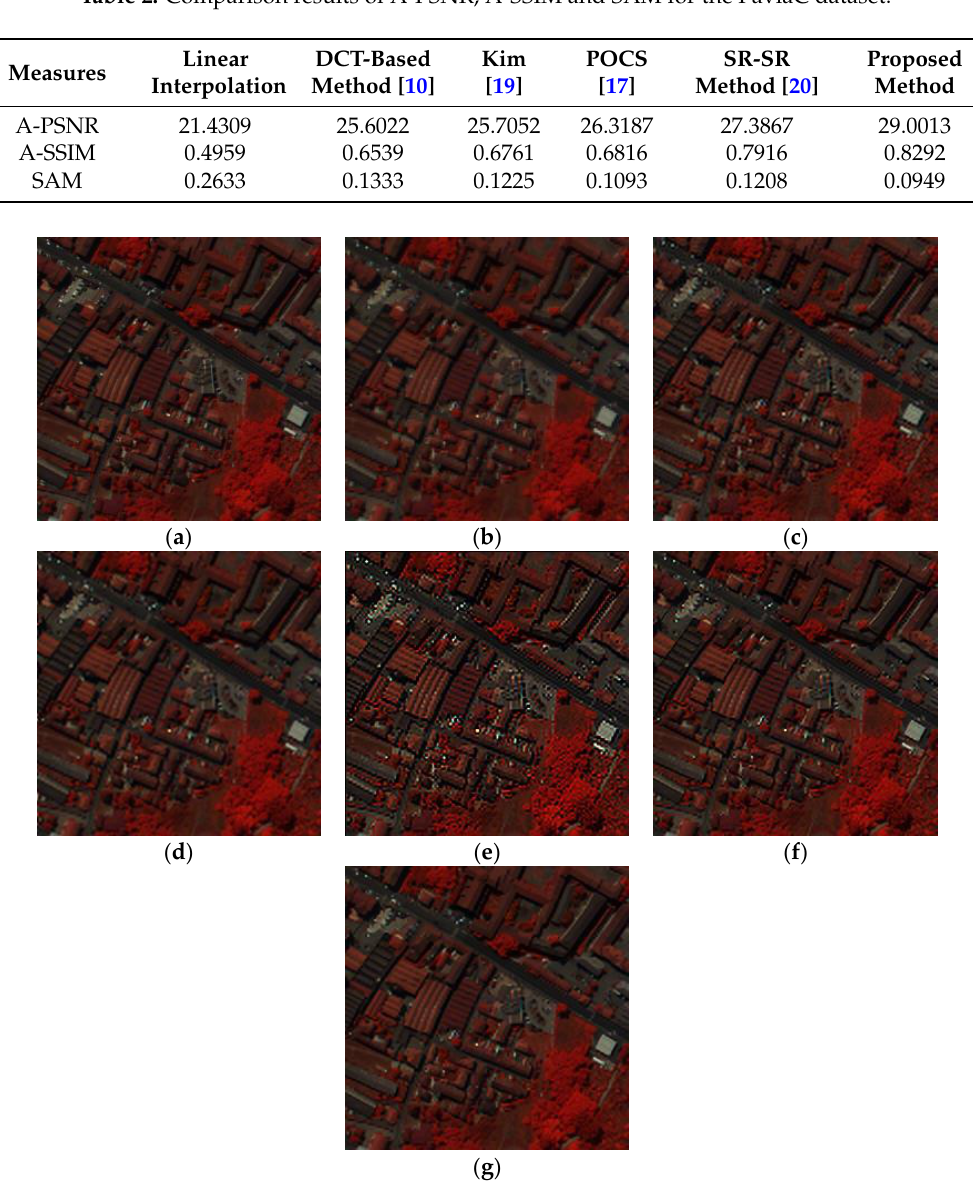
Table 1. Comparison results of A-PSNR, A-SSIM and SAM on the PaviaU dataset.